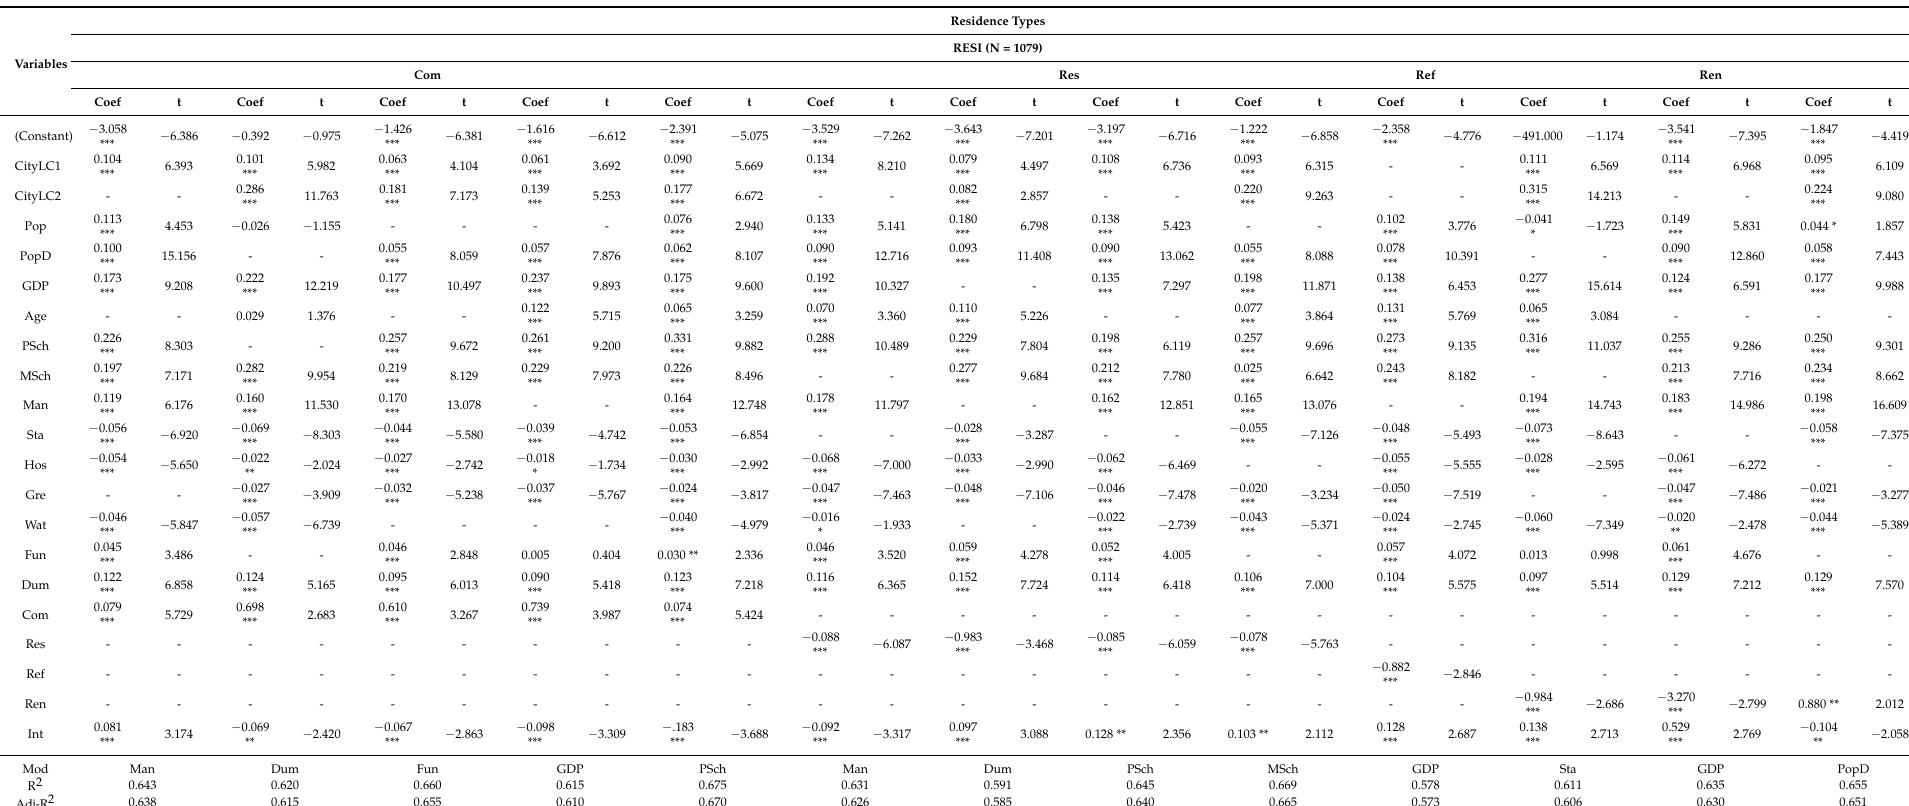
Table 10. Robust test results of interactive